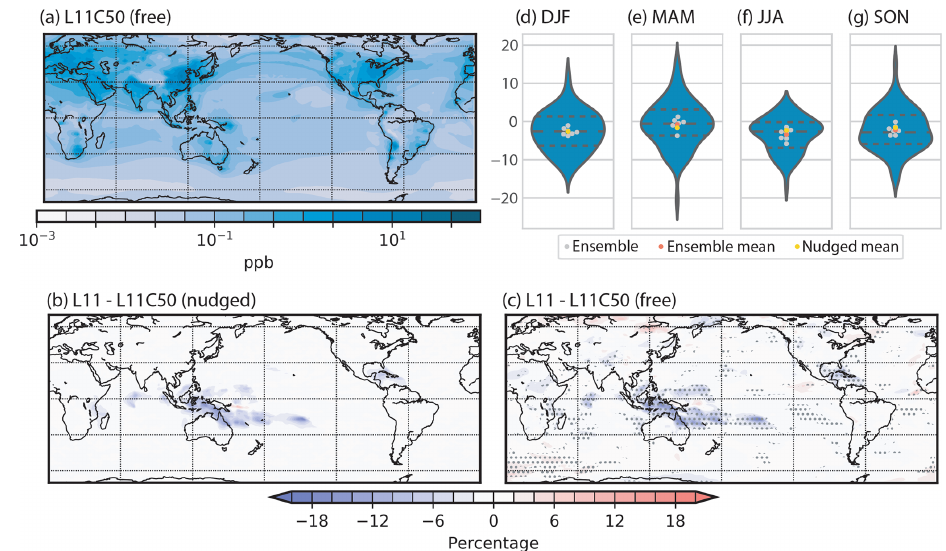
Figure 5. As for Fig. 4 but for SO 2 in parts per billion (ppb) (a) and percent (b–g) .